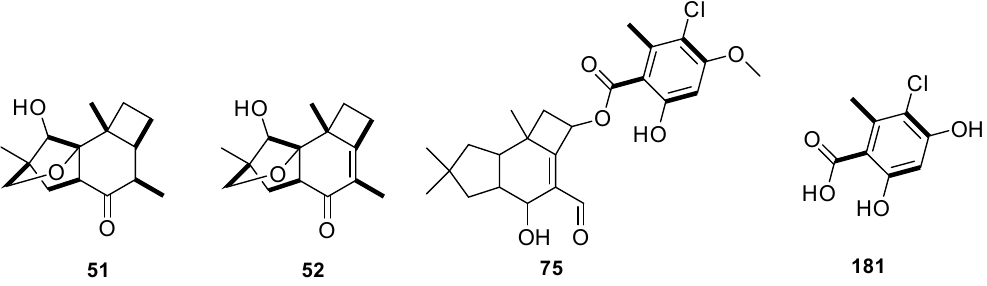
Figure 29. Structures 13 C labelled protoilludanes, illustrating the incorporation of intact acetate units (bold).